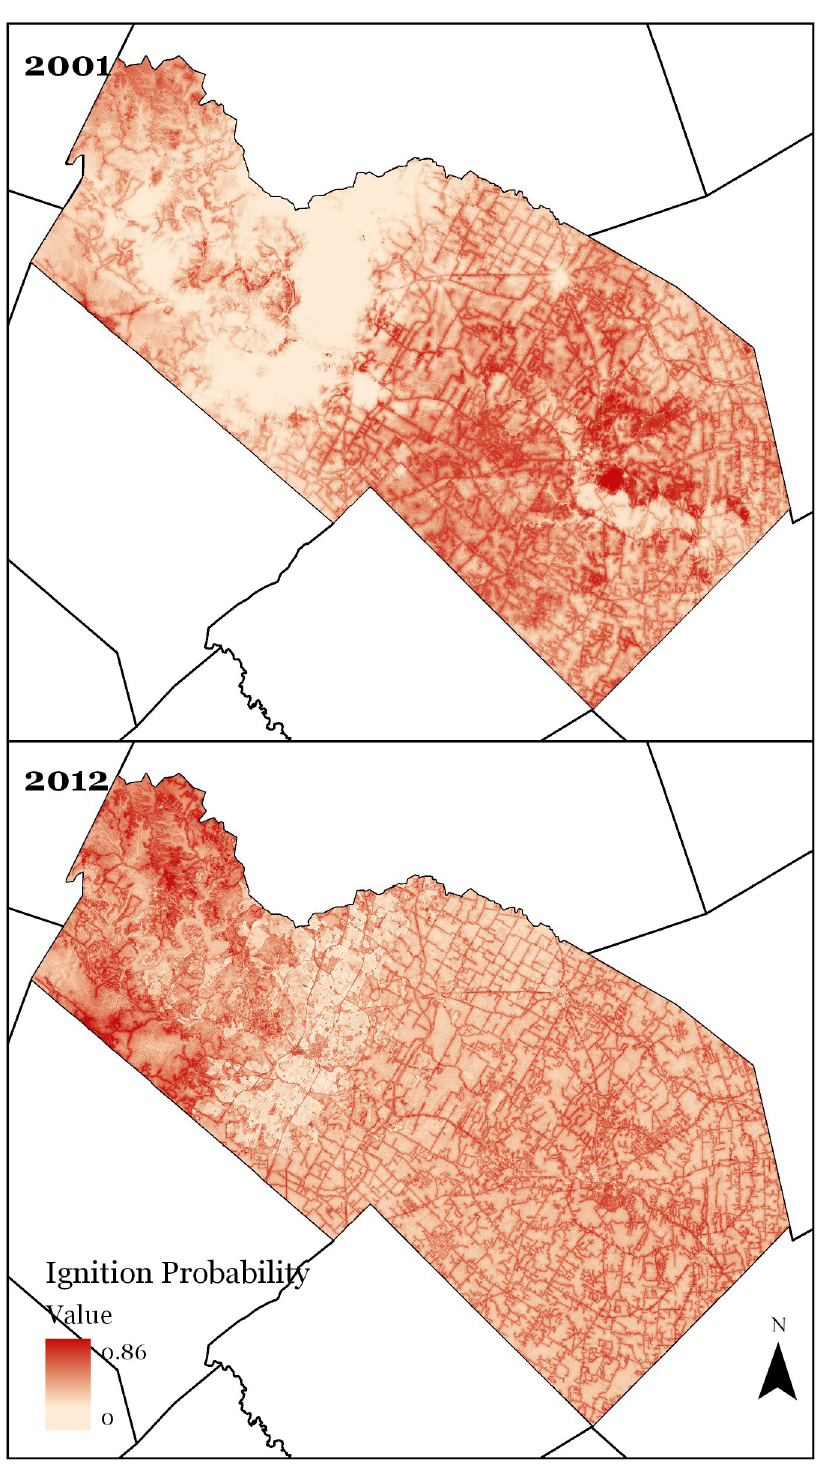
Fig 5. Variation in ignition probabilities across years. Ignition models were developed using MaxEnt software. Higher IP’s tended to occur in the Bastrop County, with the highest probabilities occurring in 2001. The basemap for this image uses census county